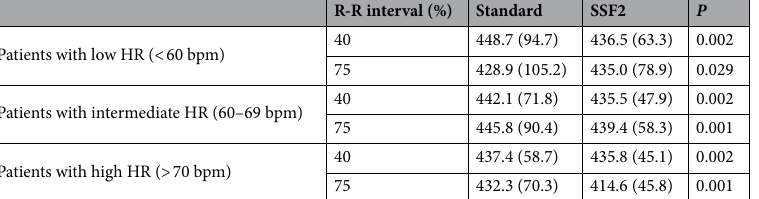
R-R interval (%) Standard SSF2 P